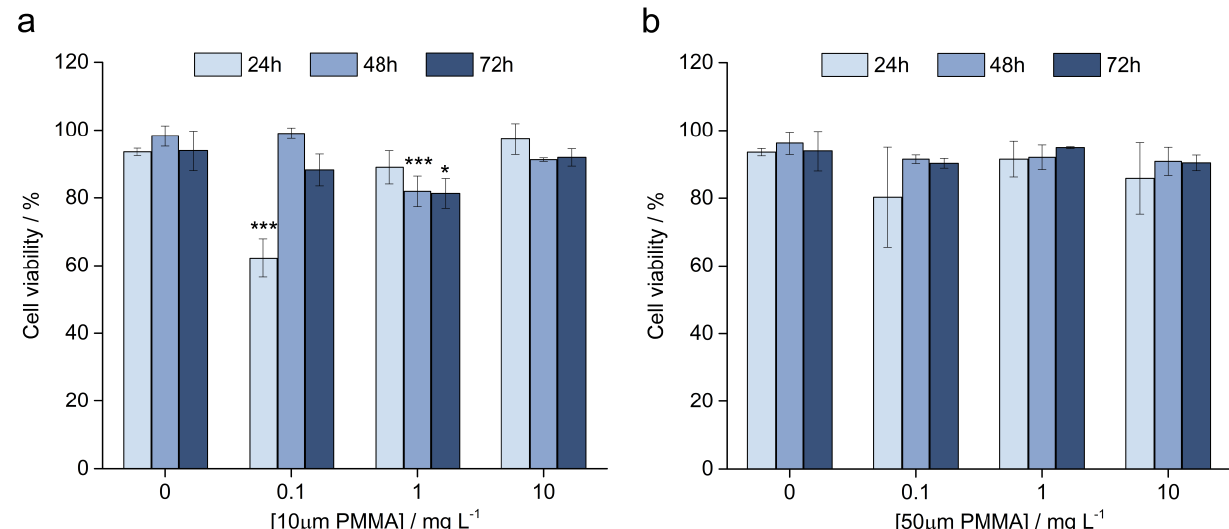
Figure 4. Cell viability (mean ± SD) after 24, 48, and 72 h for control mussels (CON) and mussels exposed to 0.1 mg L − 1 (LOW), 1.0 mg L − 1 (MID), and 10 mg L − 1 (HIGH) PMMA microparticles of ( a ) 10 µ m diameter and ( b ) 50 µ m diameter. Statistical significance is indicated at the levels * p < 0.05, *** p < 0.001.